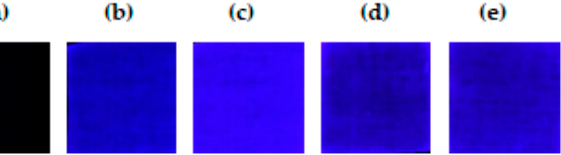
Table 1. RGB intensity of cotton fabrics: (a) treated cotton fabric, (b) EDA-CDs/CF, (c)